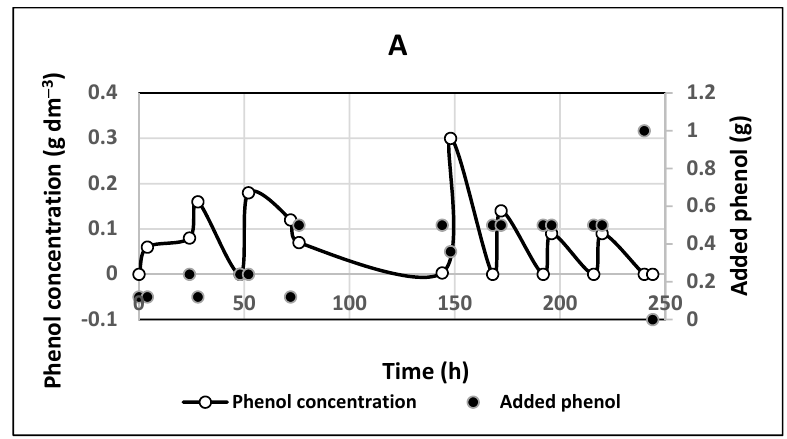
Figure 5. SEM image of the activated carbon surface with attached bacterial cells.